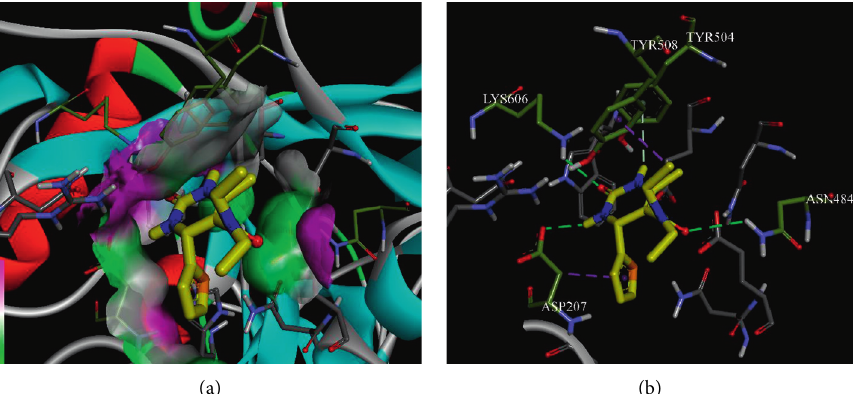
Figure 2: The binding orientation (a) and interactions (b) of compound 4i into the β -glucuronidase enzyme. Ligand 4i is displayed as yellow sticks, while the core amino acid residues are shown as green sticks. Hydrogen bonding and Pi-Pi interactions are displayed as green and pink, respectively.